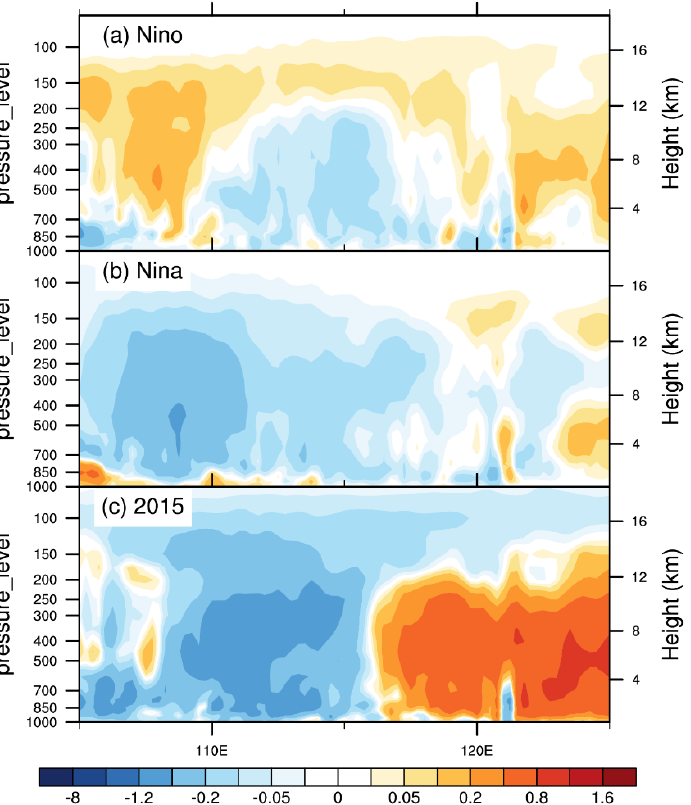
Figure 6. JJA average anomalies of the zonal mean vertical velocity (unit: Pa/s; the values are increased by − 50 times) from 20 ◦ N–30 ◦ N in ( a ) El Niño years, ( b ) La Nina years, and ( c ) 2015 from ERA5 reanalysis datasets. Left axis stands for pressure levels (unit: hPa) and right axis stands for the height (unit: km).